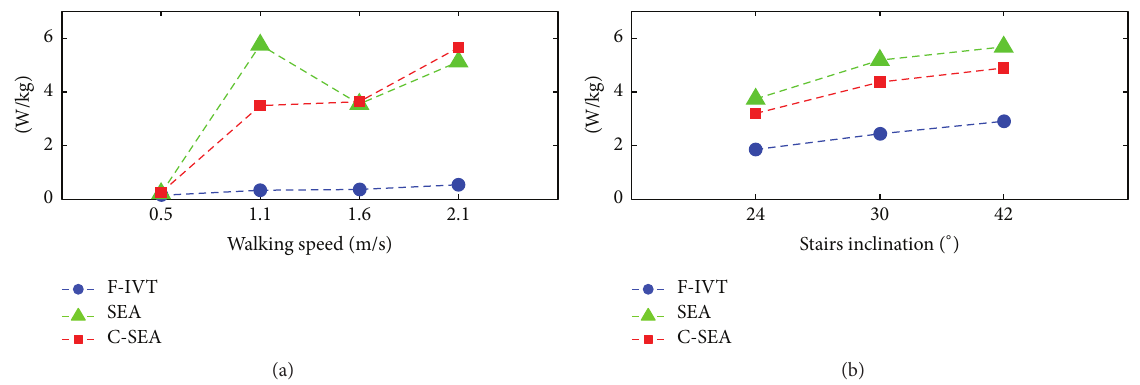
Figure 8: Electric peak power of the motors of the actuators compared (F-IVT, SEA, and C-SEA) in level ground walking at different speeds (a) and in stairs climbing at different inclinations